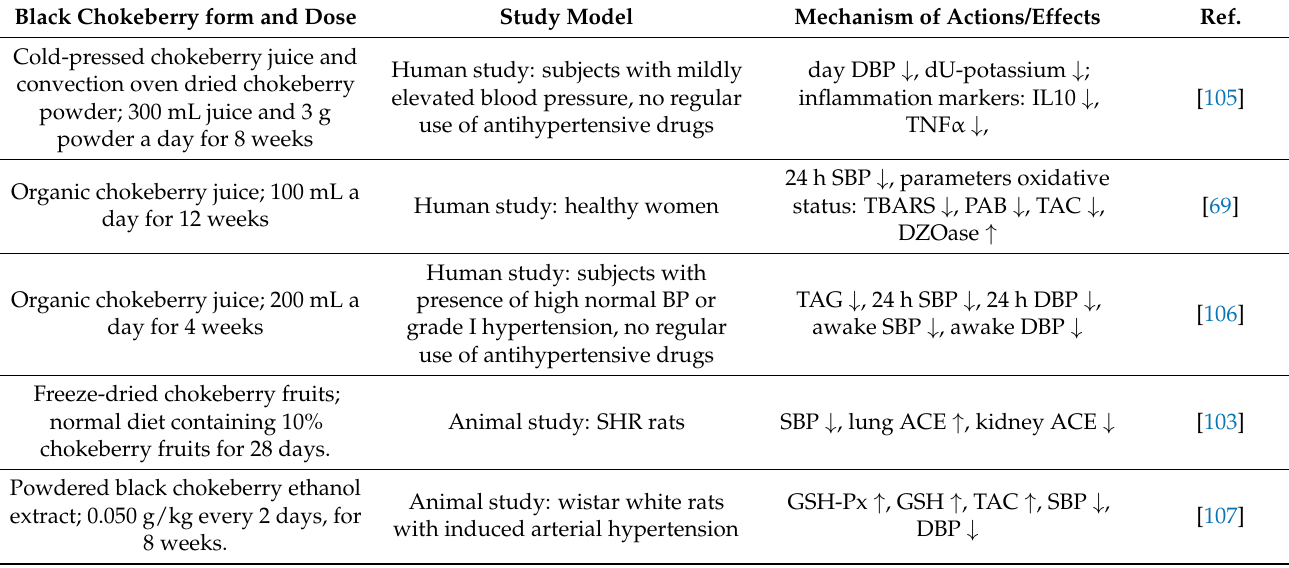
Table 2. Selected human and animal studies concerning effects of black chokeberry on hypertension. Black Chokeberry form and Dose Study Model Mechanism of Actions/Effects